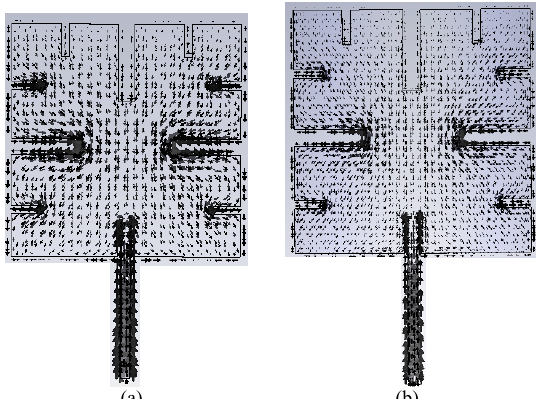
Figure 5: The simulated field distribution at 1.575GHz (a)2nd iteration of planar antenna (b)2nd iteration of conformal antenna with 60mm